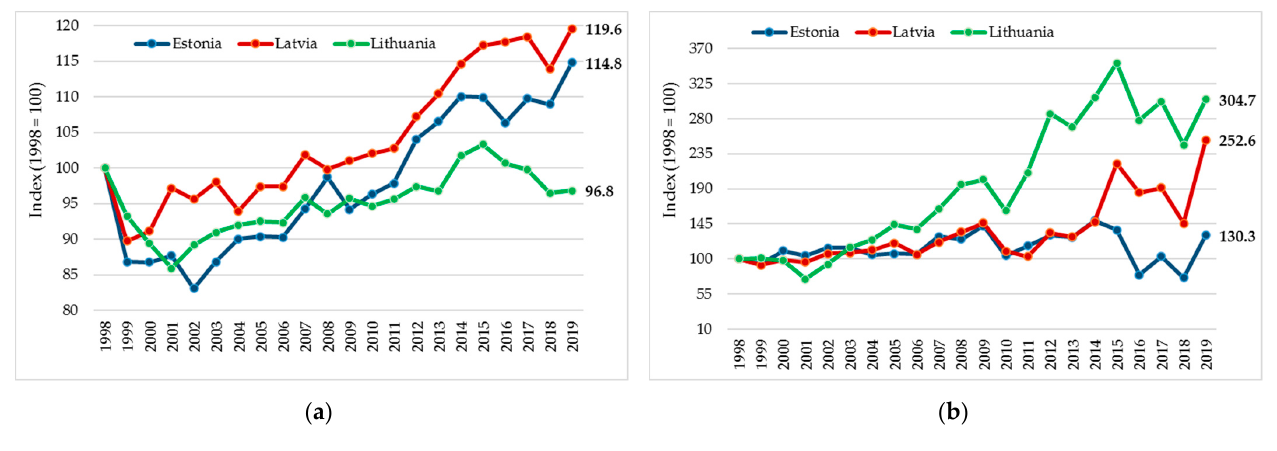
Figure 2. Baltic states time series: ( a ) Carbon emissions equivalent of greenhouse gases (GHG); ( b ) Gross value added generated by agriculture (GVA). Source: authors’ calculations based on Eurostat [9,70] data, 2022. Table 1. Descriptive statistics of carbon emissions equivalent of greenhouse gases (GHG) and gross value added generated by agriculture (GVA)